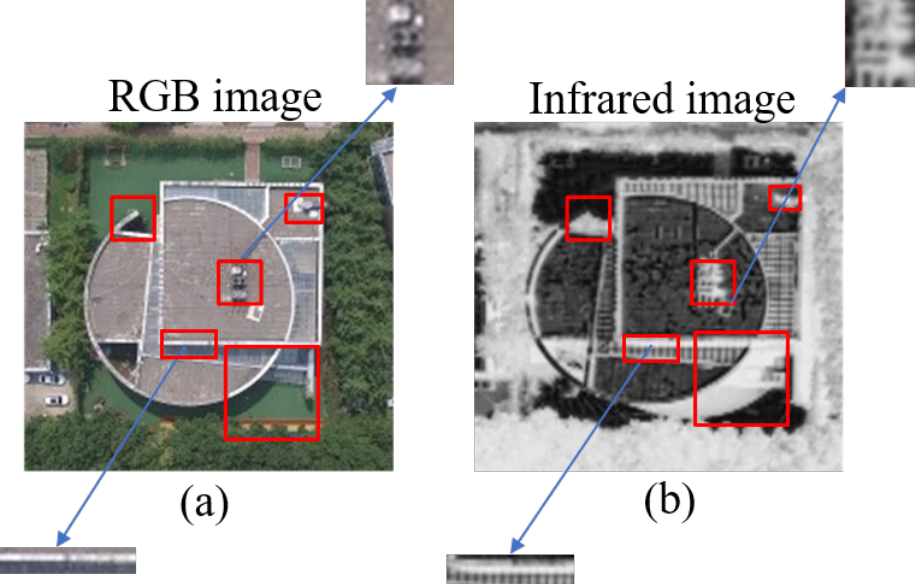
Figure 2. Different image-forming principles in sensors will cause extreme appearance changes on images. ( a ) is the RGB image sample and ( b ) is the infrared image